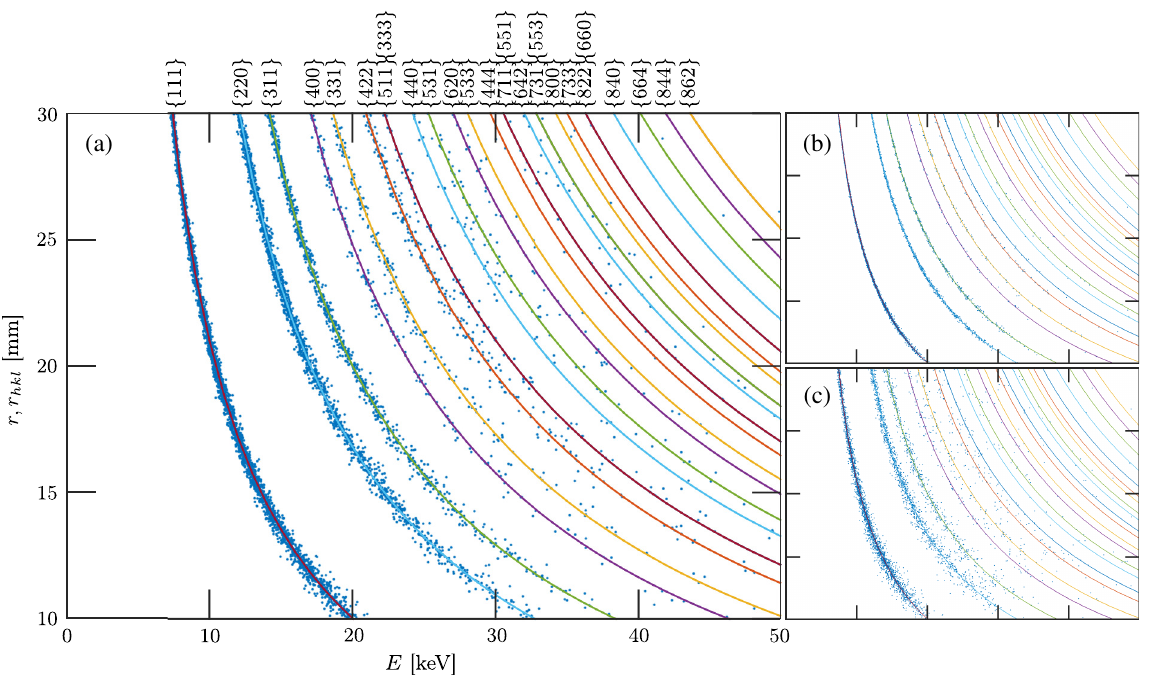
FIG. 4. Scatter plots of radial distance r from the beam axis as a function of photon energy. The solid lines show the radii of the Debye-Scherrer rings r hkl for photons incident along the beam axis. The assumed properties of the incident beam used for Fig. 4(a) are as in the data shown in Fig. 3(a), with σ φ ¼ 2 . 5 mrad. Figures 4(b) and 4(c) show the plots for simulations with σ φ ¼ 1 . 0 mrad and σ 5 . 0 mrad, φ ¼